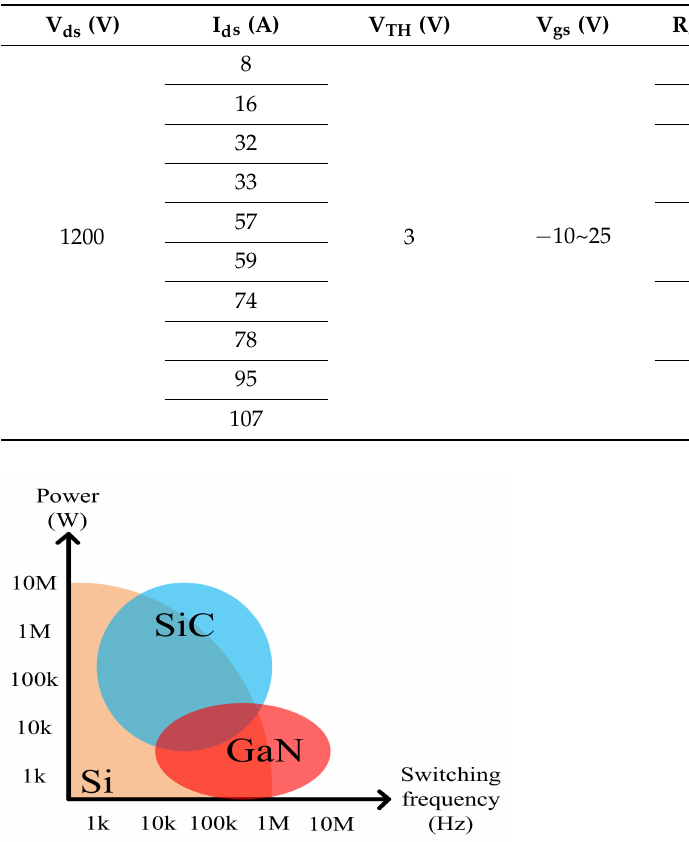
Table 12. Commercial 600~1200 V SiC MOSFETs by GeneSiC.